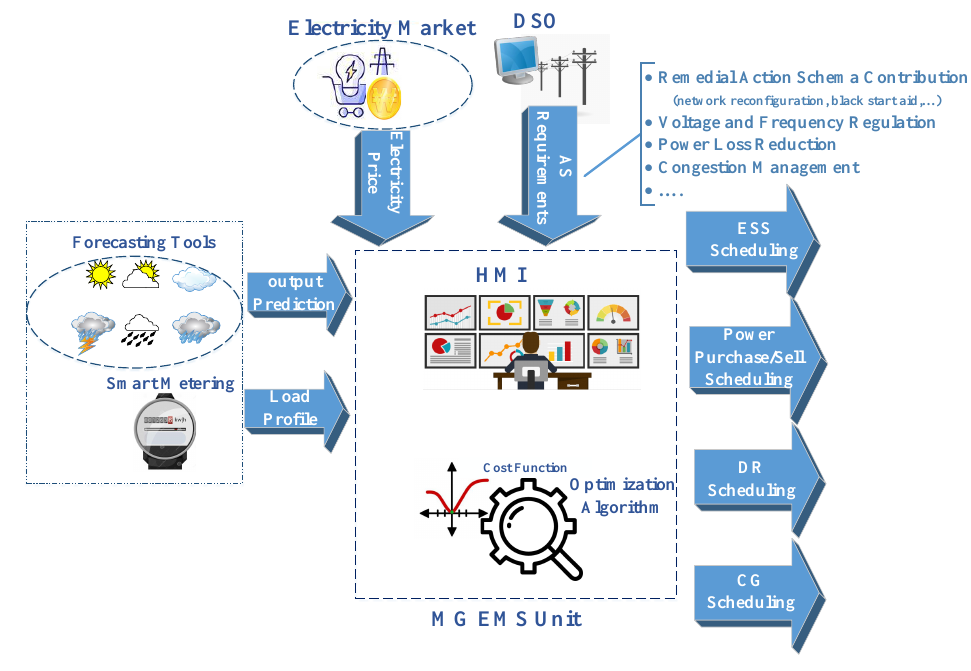
Figure 4. A MG EMS unit under the concept of